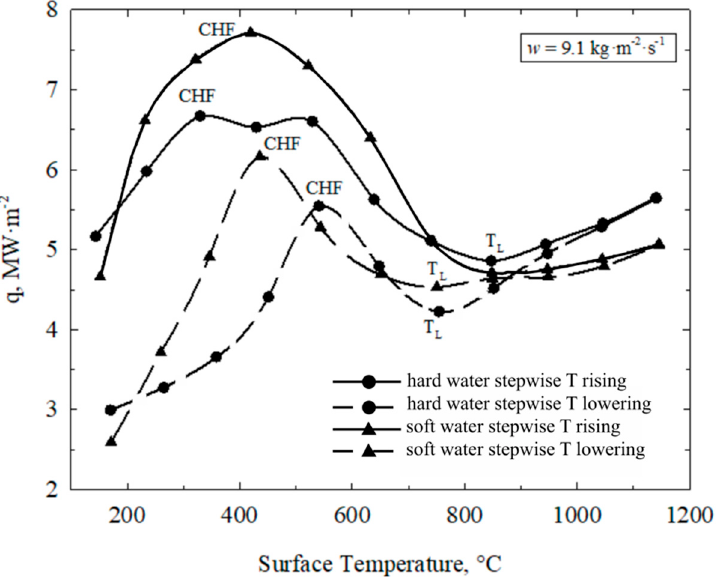
Figure 5. Experimentally determined steady-state boiling curves when using a low water impinge- ment density of 9.1 kg·m − 2 s − 1 delivered by a Delavan nozzle and using hard and soft water-air mists. On the other hand, Figure 5 also shows a difference between the boiling curves obtained with soft and hard water. The heat fluxes obtained using soft water exceed those values measured using hard water-air mists, except at wall temperatures above 900 ◦ C. These temperatures correspond to the stable vapor layer regime, above the Leidenfrost temperature. In this case, radiation heat losses become important. The emissivity of salt layer is ~0.9 [19] while the emissivity of platinum is ~0.2. This means that, for a given surface temperature, a salt layer improves the heat flux by radiation with respect to the value for a cleaner platinum surface. Below 900 ◦ C, the heat flux obtained with hard water-air mist is smaller due to the effect of increasing surface roughness, as explained above. The overall peak CHF was obtained during stepwise T increases and using soft water-air mist, rating a value of ~7.8 MW · m − 2 . The corresponding CHF obtained with hard water air-mist was ~6.7 MW · m − 2 . Another difference in the heat flux curves obtained with soft and hard water-air mists is the surface temperature at CHF, which is higher when using hard water-air mist. Figure 6a,b show some photomicrographs and chemical analysis of a sample surface after testing using hard water-air mist. Figure 6a shows Scanning Electron Microscopy (SEM) and Energy Dispersive Spectroscopy (EDS) (PHILIPS Model XL30, FEI COMPANY, Eindhoven, the Netherlands) analysis for the platinum surface (gray area) and Figure 6b shows the corresponding analysis for the surface of the salt layer. The increased surface roughness improves the rate of vapor nucleation, which decreases the contact area between liquid and solid wall, as discussed previously [1]. Moreover, it should be mentioned that hysteresis can be suppressed by cleaning the sample’s surface to remove the salt layer after completing stepwise T increases up to 1200 ◦ C